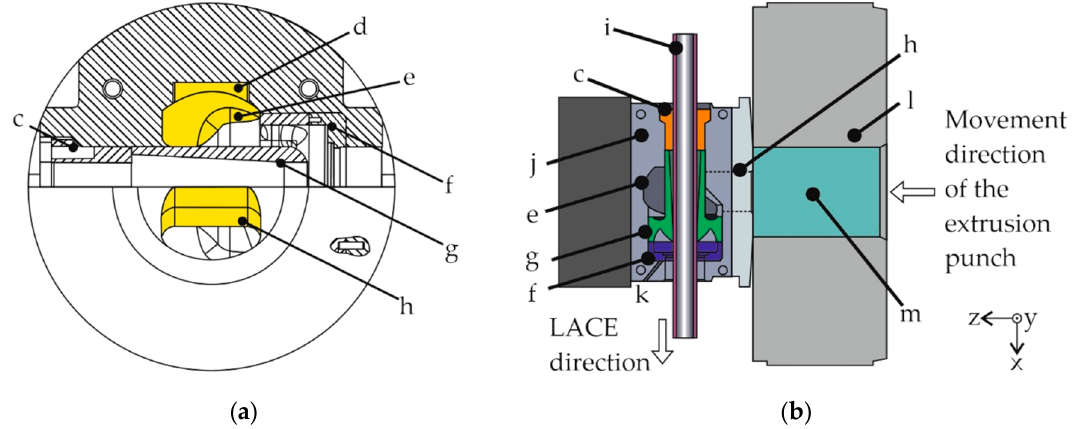
Figure 2. ( a ) Schematic illustration with sectional plane lengthwise through the tool with c: clamping cover, d: pocket, e: deflection, f: die, g: mandrel part with three support arms, h: inlet (the geometry of the inlet and deflection are highlighted); ( b ) schematic illustration of the concept for the 10 MN extrusion press in longitudinal section with i: reinforcing element, j: die housing, k: thermocouple bore, l: container, m: aluminum billet.